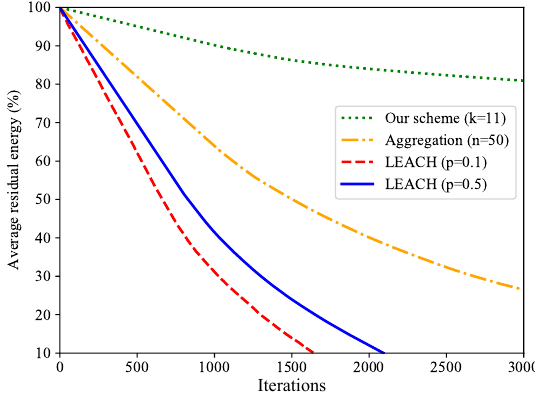
Figure 6. Comparative analysis for network